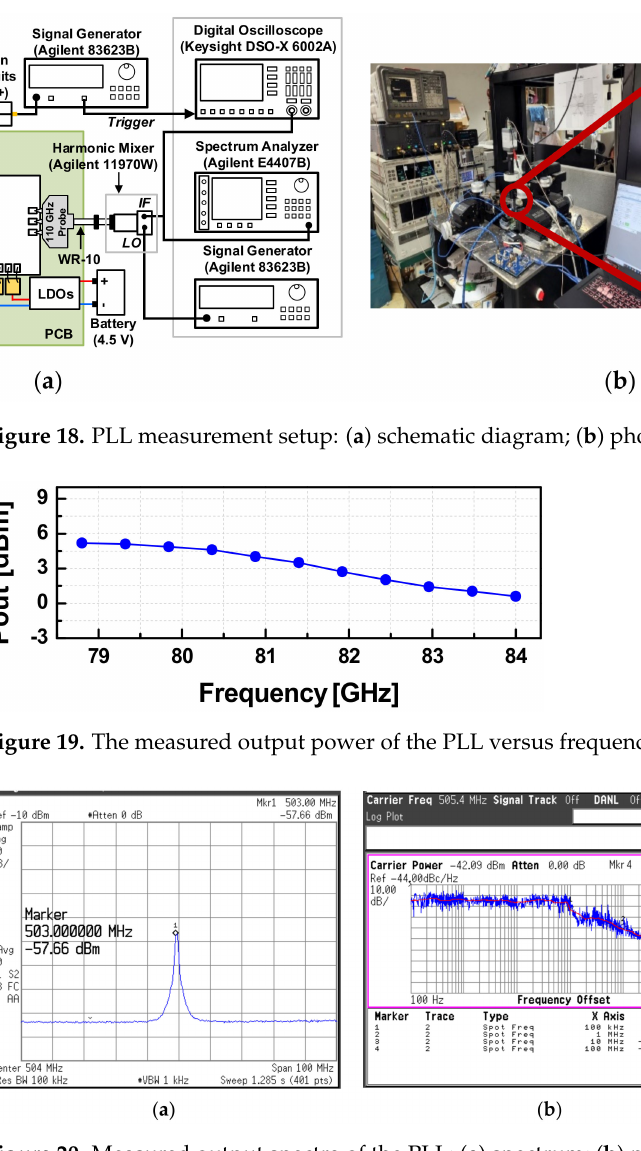
Figure 20. Measured output spectra of the PLL: ( a ) spectrum; ( b ) phase